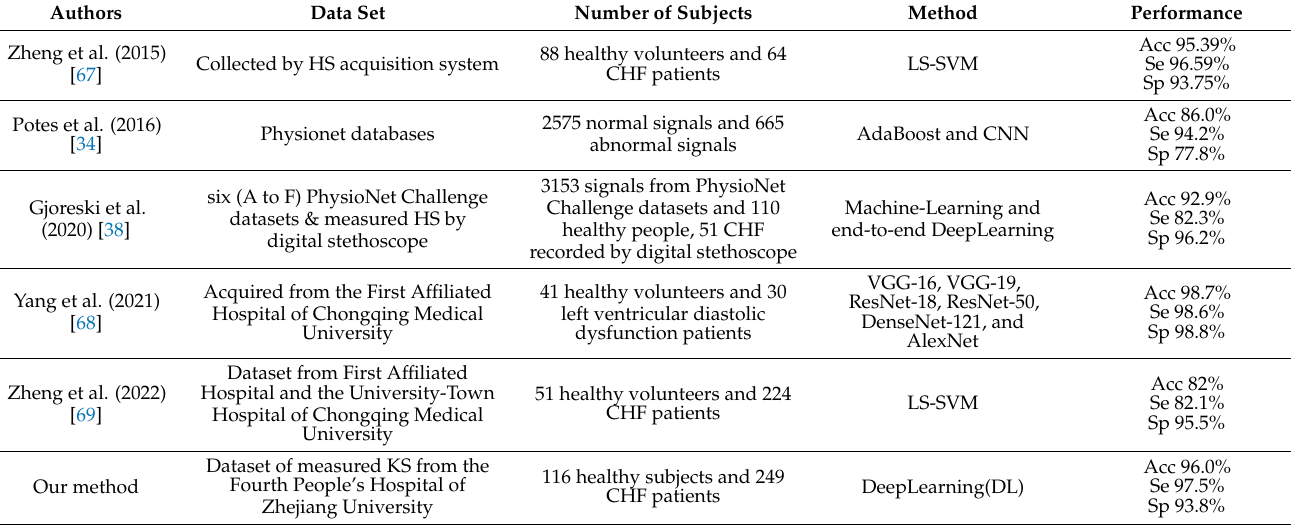
Table 6. Comparison of HF classification algorithms based on